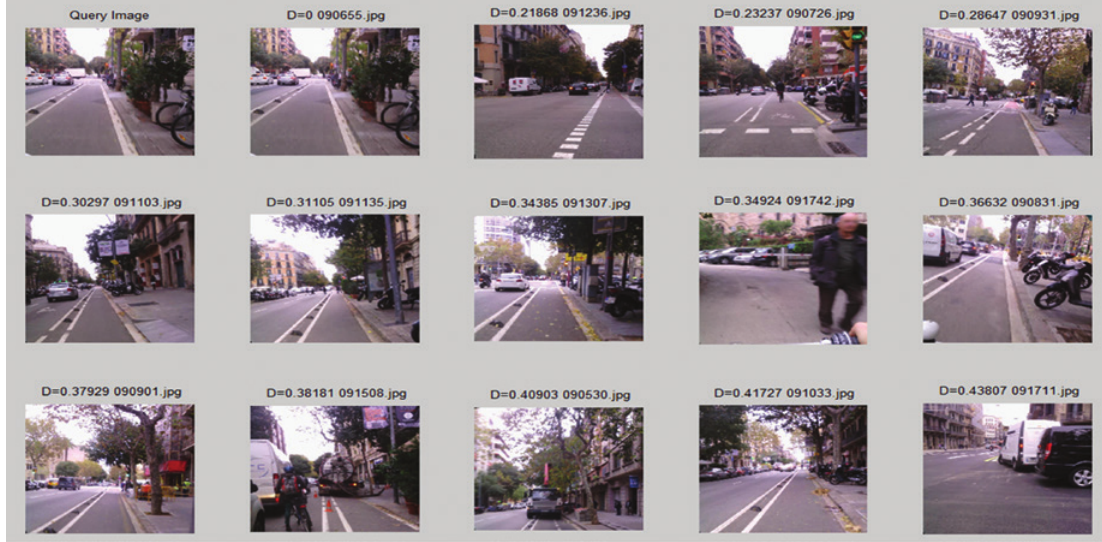
Figure 5: The most similar images of a query image at the top left corner using the histobin distance.